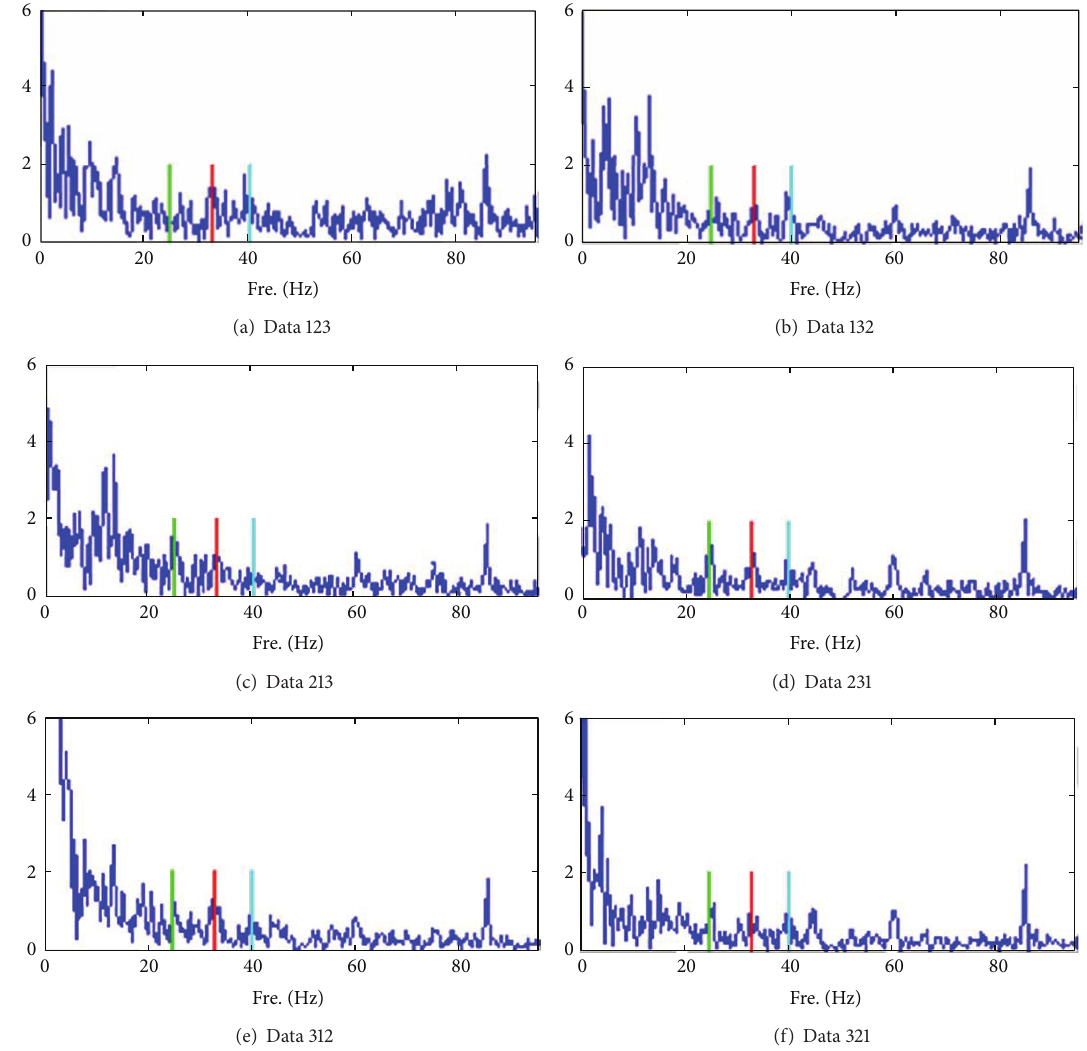
Figure 11: The FFT of